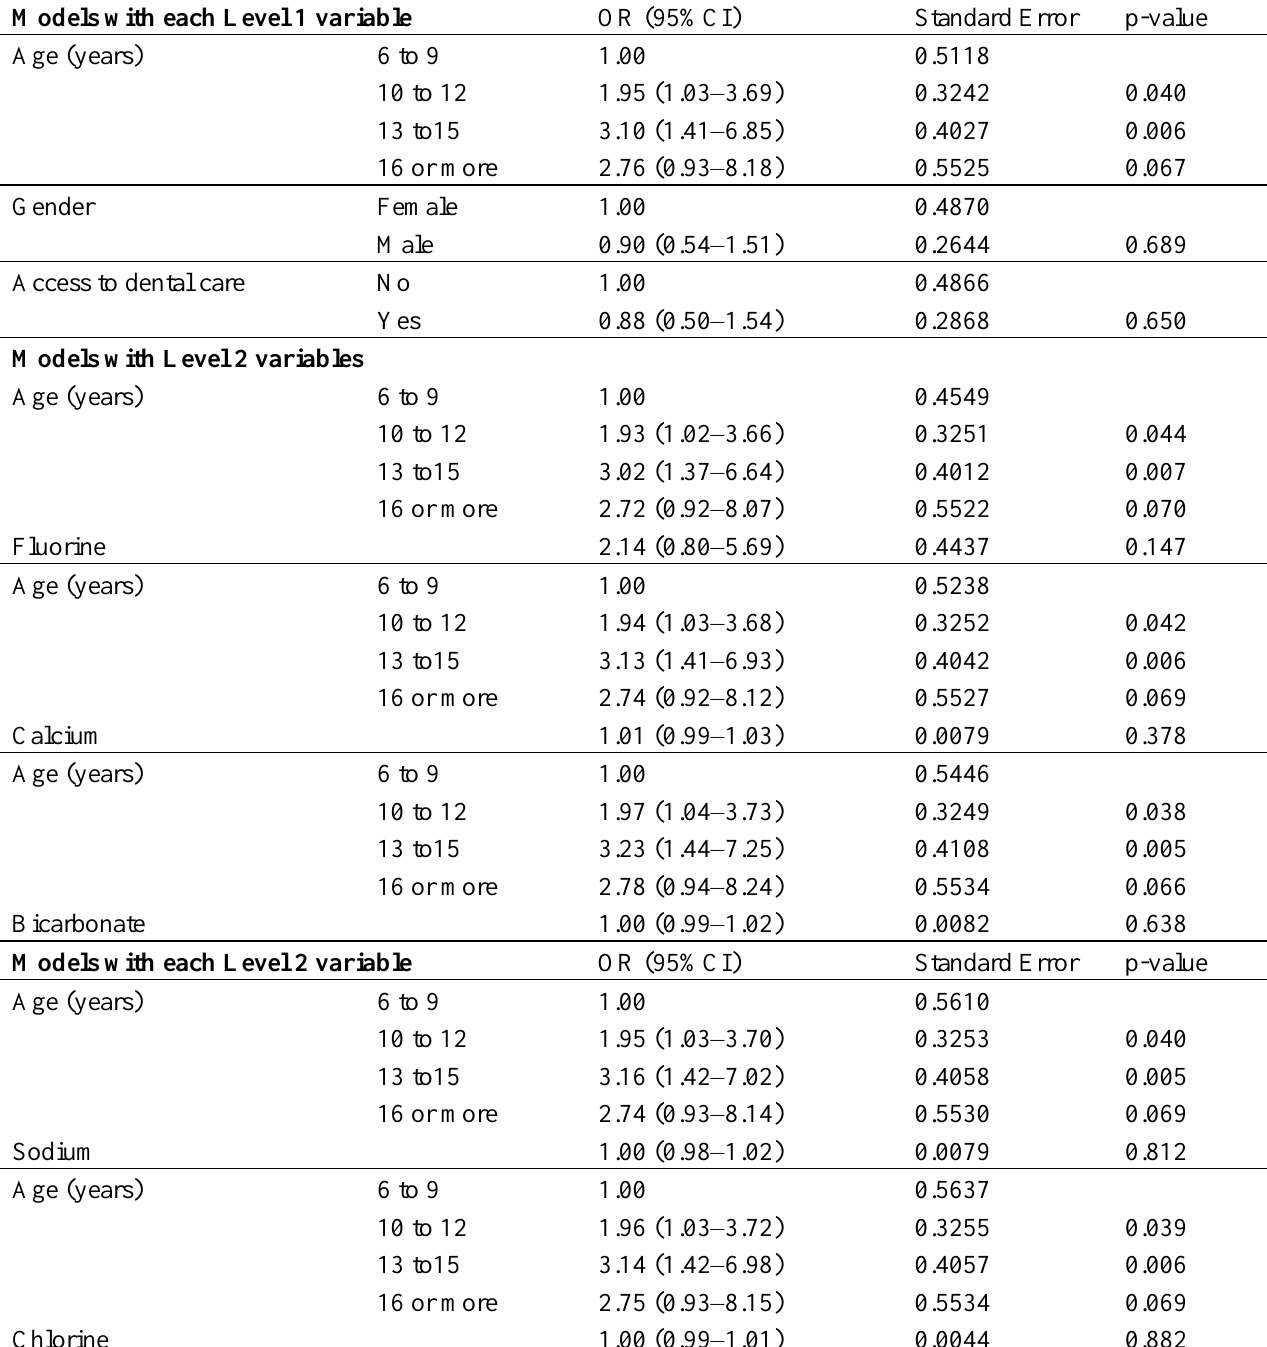
Table 4. Multilevel models for variables associated to the presence or absence of TF ≥ 5 dental fluorosis in rural communities of São Francisco and Verdelândia,